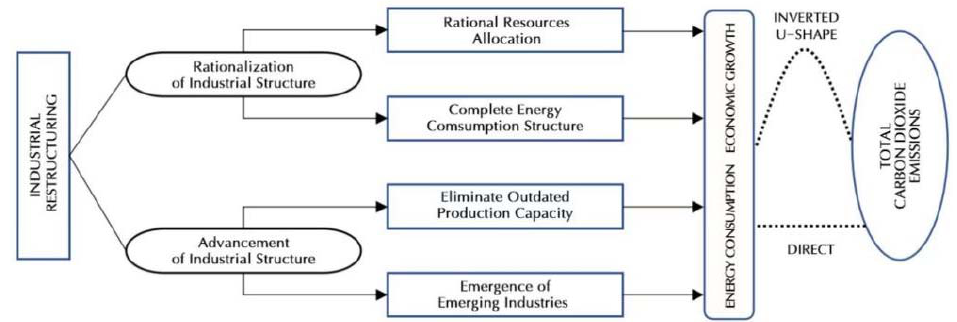
Figure 1. Analysis framework for the impact mechanism of industrial structure adjustment on carbon dioxide emissions.